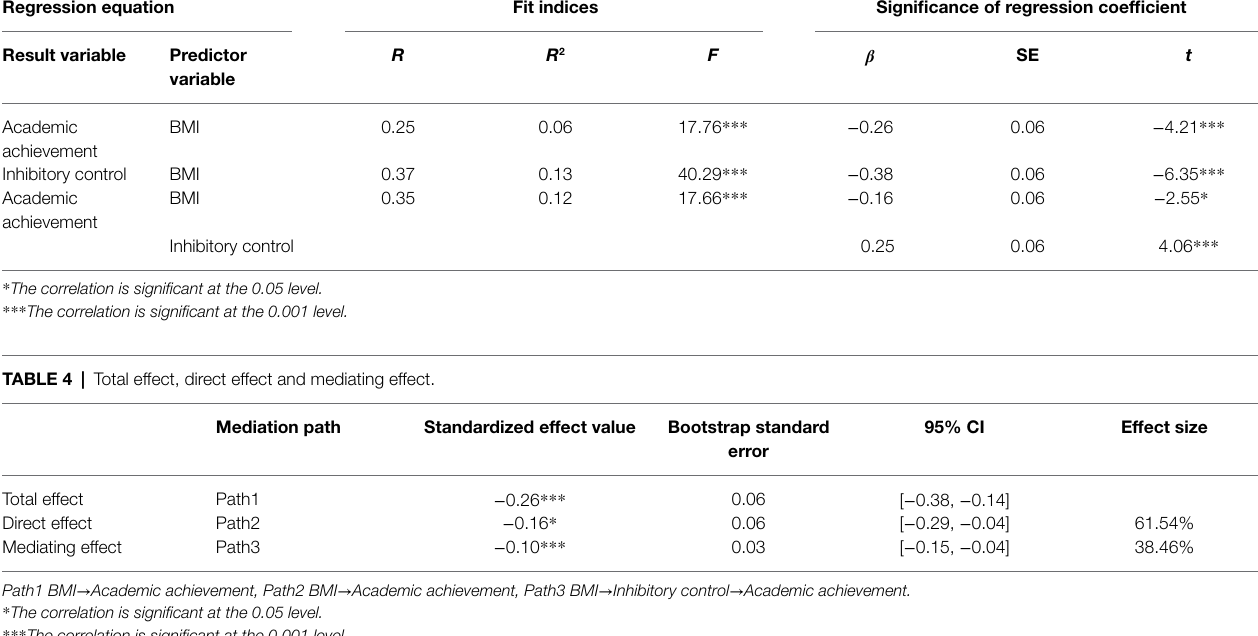
TABLE 3 | The mediating effect of the inhibitory control on the relationship between BMI and academic achievement. Regression equation